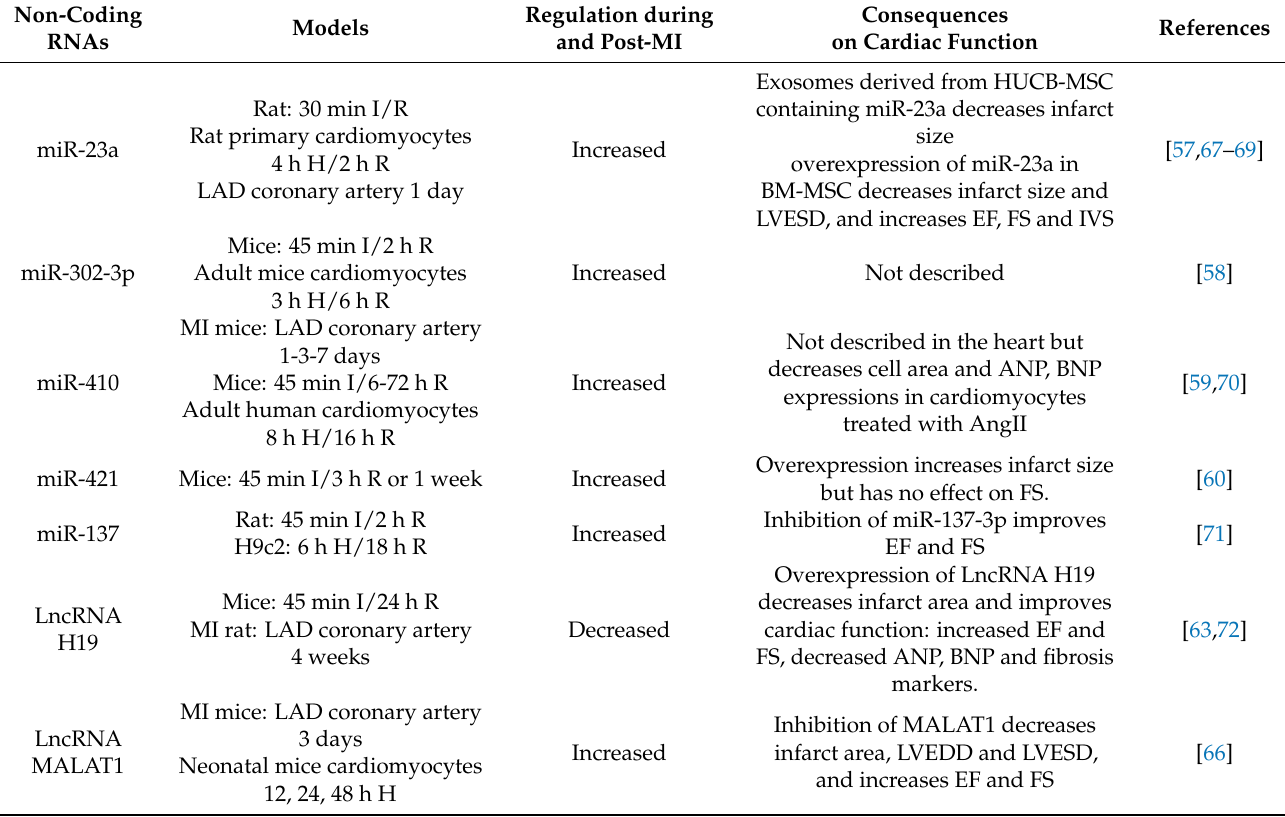
Table 2. Expression of non-coding RNA during and post-MI and their role on cardiac